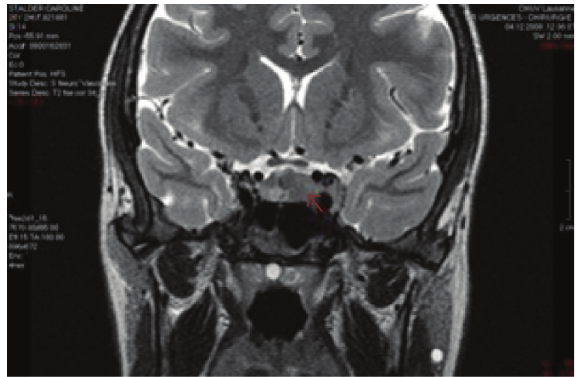
Figure 1: Cranial computed tomography shows a mass of 20 × 20 × 13 mm in the left part of the sella turcica.